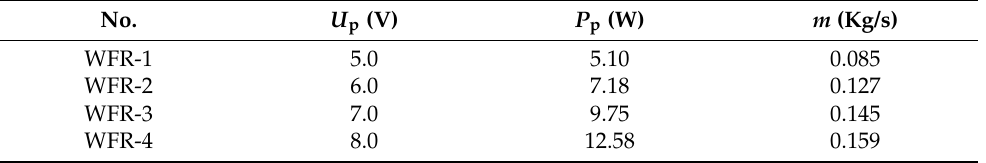
Table 6. Experimental cases for optimization of the water flow